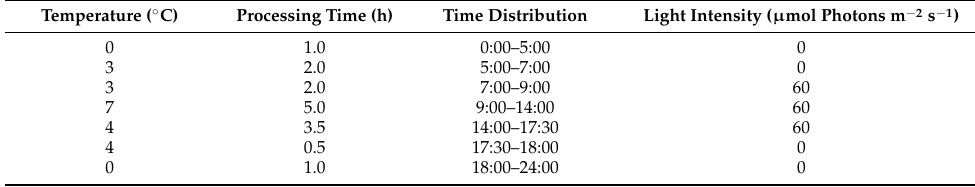
Table 1. The artificial dormancy induction